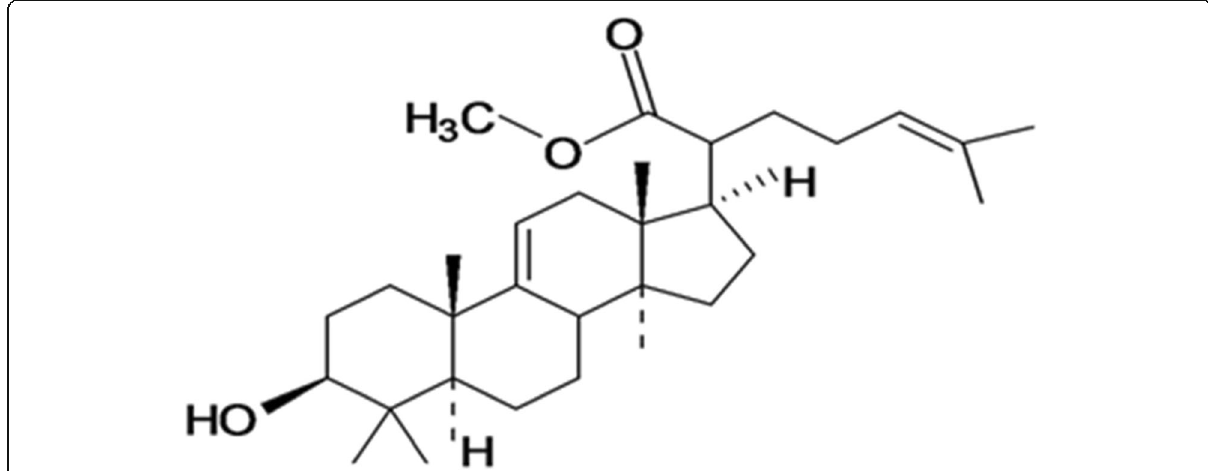
Fig. 1 Chemical structure of lanosteryl triterpene